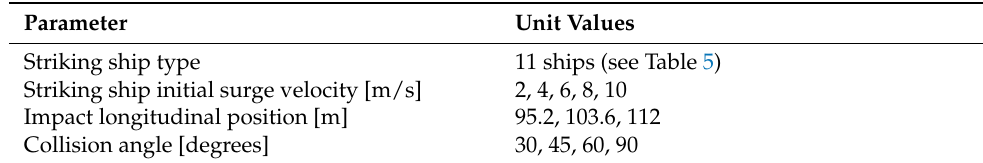
Table 4. Parameters used in collision crash analysis.